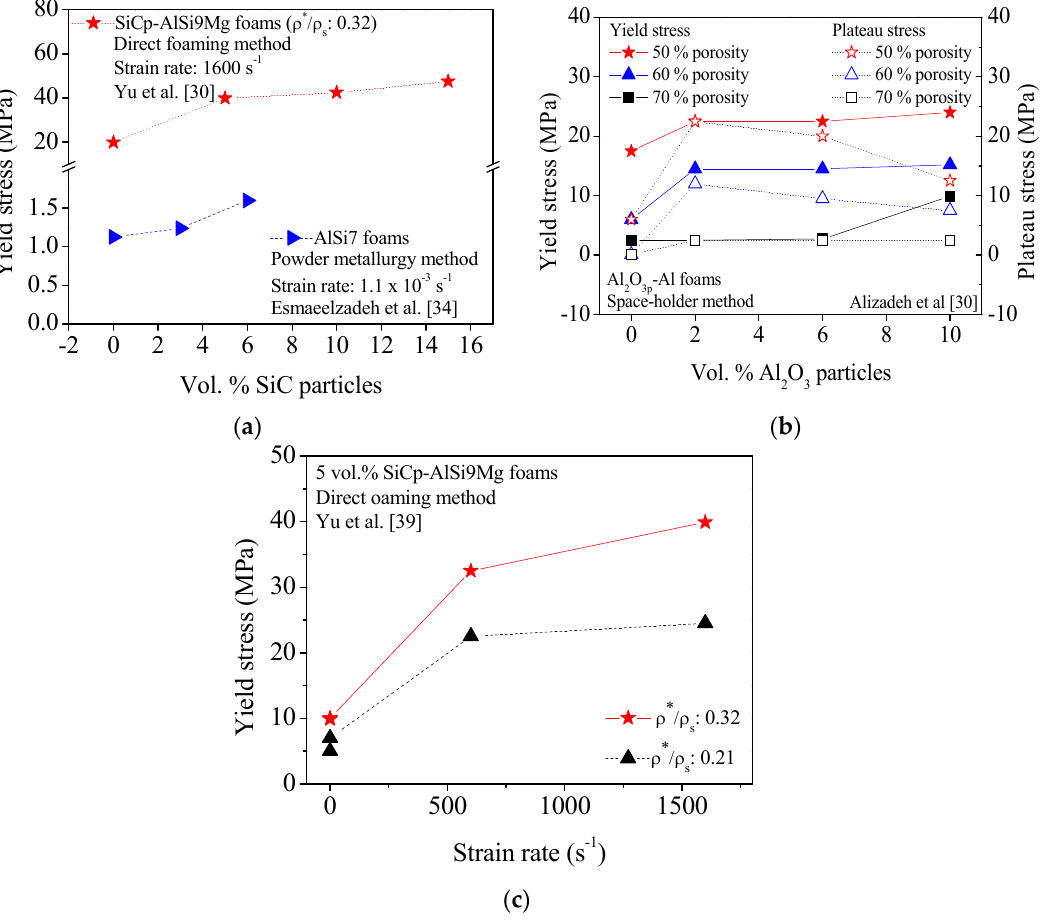
Figure 2. Effect of the volume fraction of particles on the yield stress ( a , b ) and plateau stress ( b ) of foams containing SiC (SiCp) ( a ), and Al 2 O 3 particles ( Al 2 O 3 p) ( b ). Effect of strain rate on compressive behavior of reinforced foams containing 5 vol.% SiC particles is displayed in ( c ).